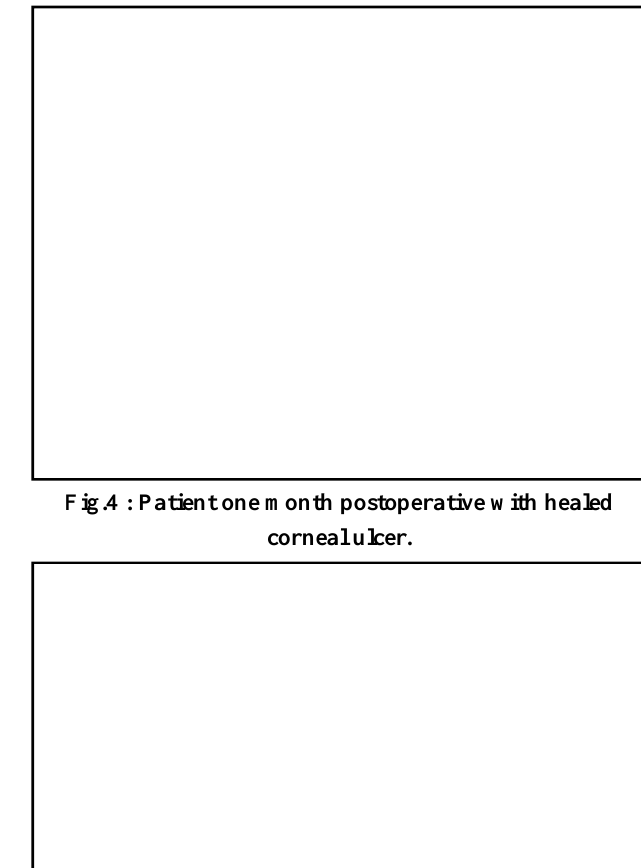
Fig.1 : Twenty two year old male with left upper lid cicatricial ectropion and hypopyon corneal ulcer.